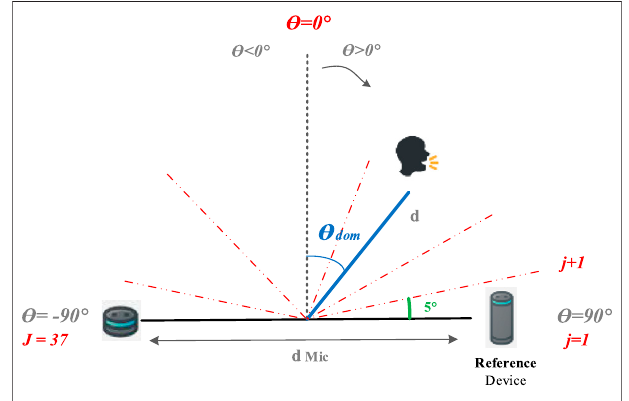
FIGURE 4 | The space is divided into J parts. The elements of the ground-truth range in [1..J] Adapted from Zarazaga et al. (2021).